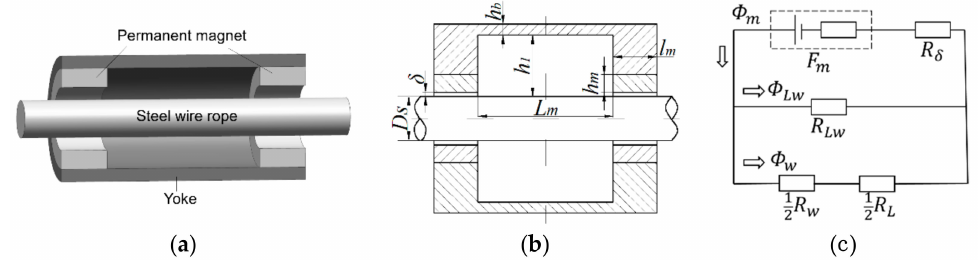
Figure 2. Schematic of the CMPME: ( a ) Three-dimensional structure; ( b ) Two-dimensional structure; ( c ) Equivalent simplified magnetic